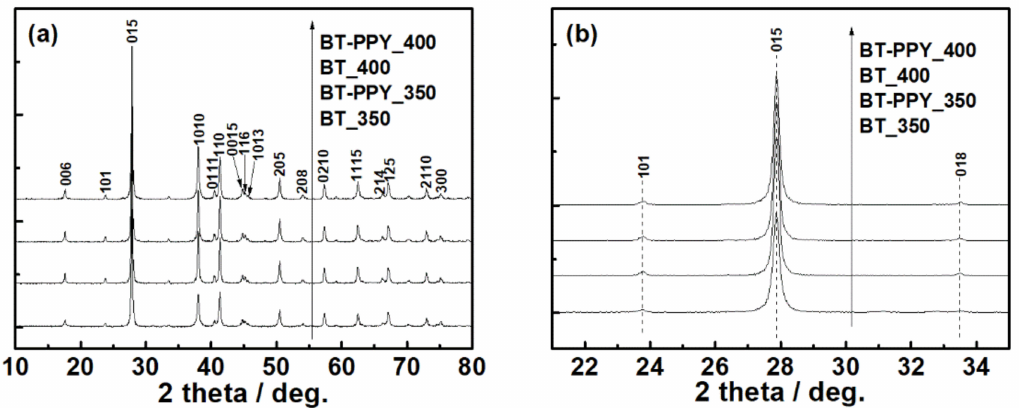
Figure 2. ( a ) XRD patterns of pristine Bi 2 Te 3 (BT) and Bi 2 Te 3 –polypyrrole (BT-PPY), which were individually sintered at 350 and 400 ◦ C; ( b ) enlarged XRD plots of the BT and BT-PPY over a 2 θ range from 21 ◦ to 35 ◦ .